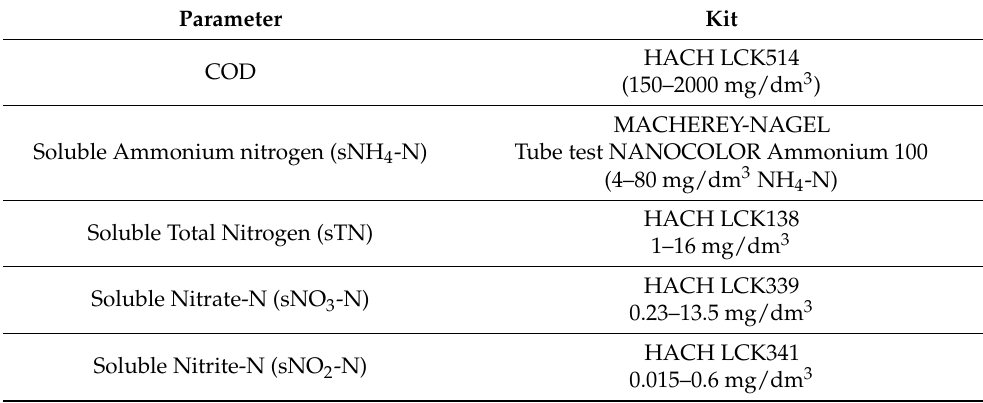
Table 2. Description of the kits that were used for the analysis of the digestate